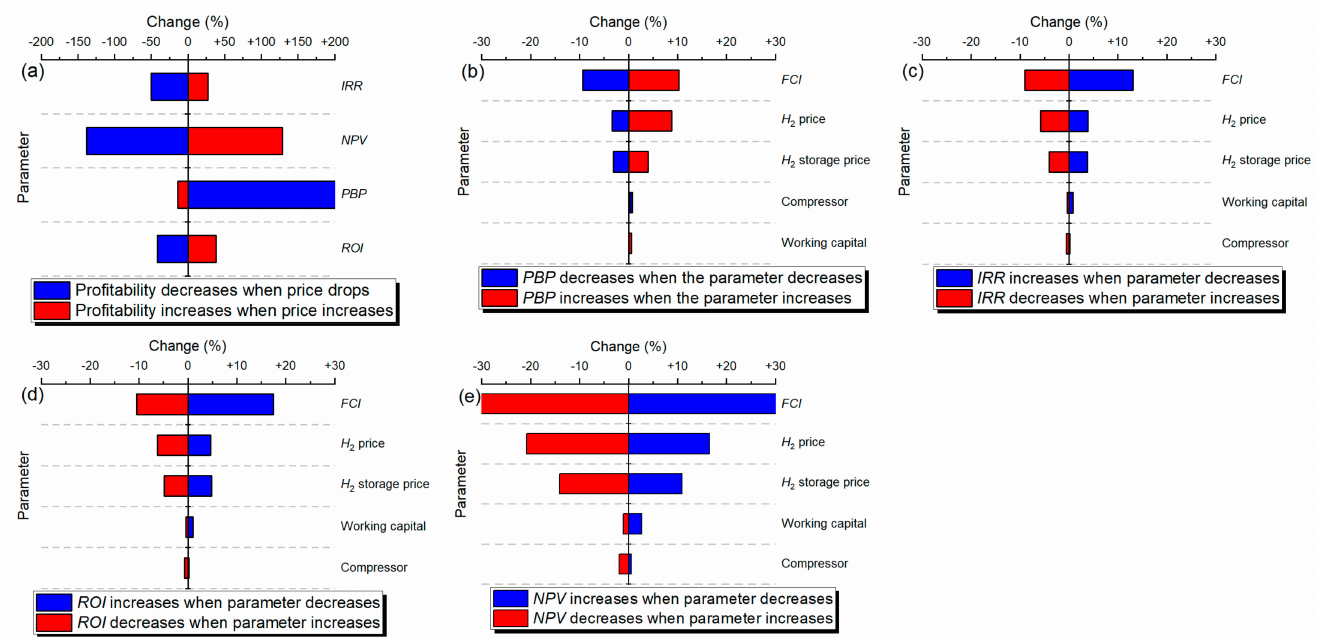
Figure 4. Sensitivity analysis tornado plots for ( a ) the biomethane price according to all of the economic metrics, ( b ) PBP , ( c ) IRR , ( d ) ROI , and ( e ) NPV